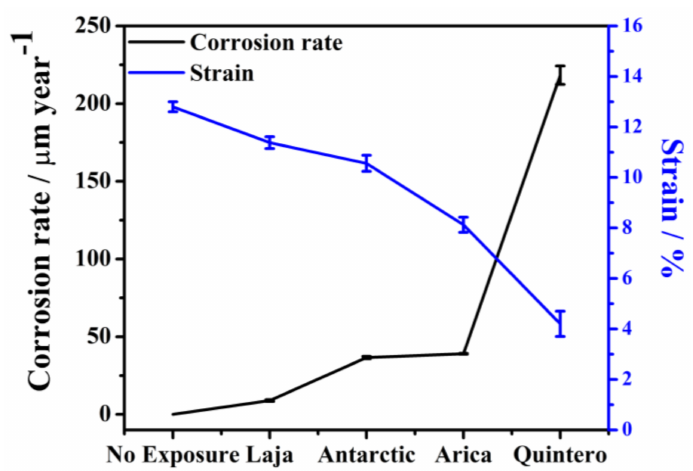
Figure 10. Relationship between corrosion rate and strain of exposed steel in different locations after 36 months of